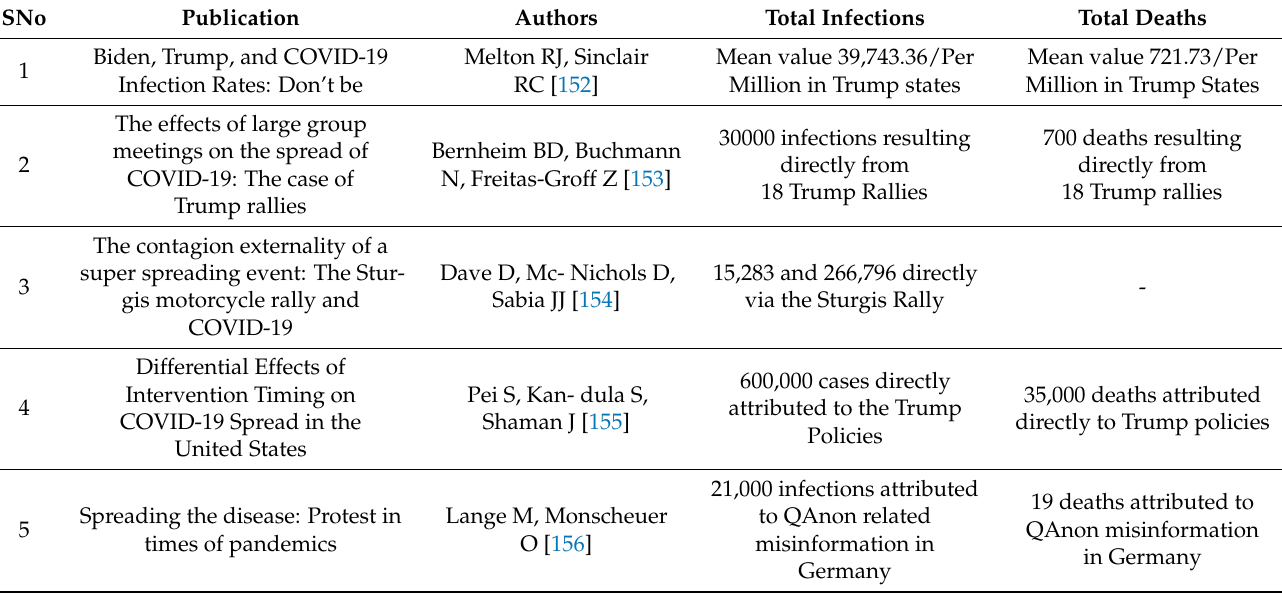
Table 1. Estimates of COVID-19 infections stemming from Q Anon and Donald Trump-related policies and